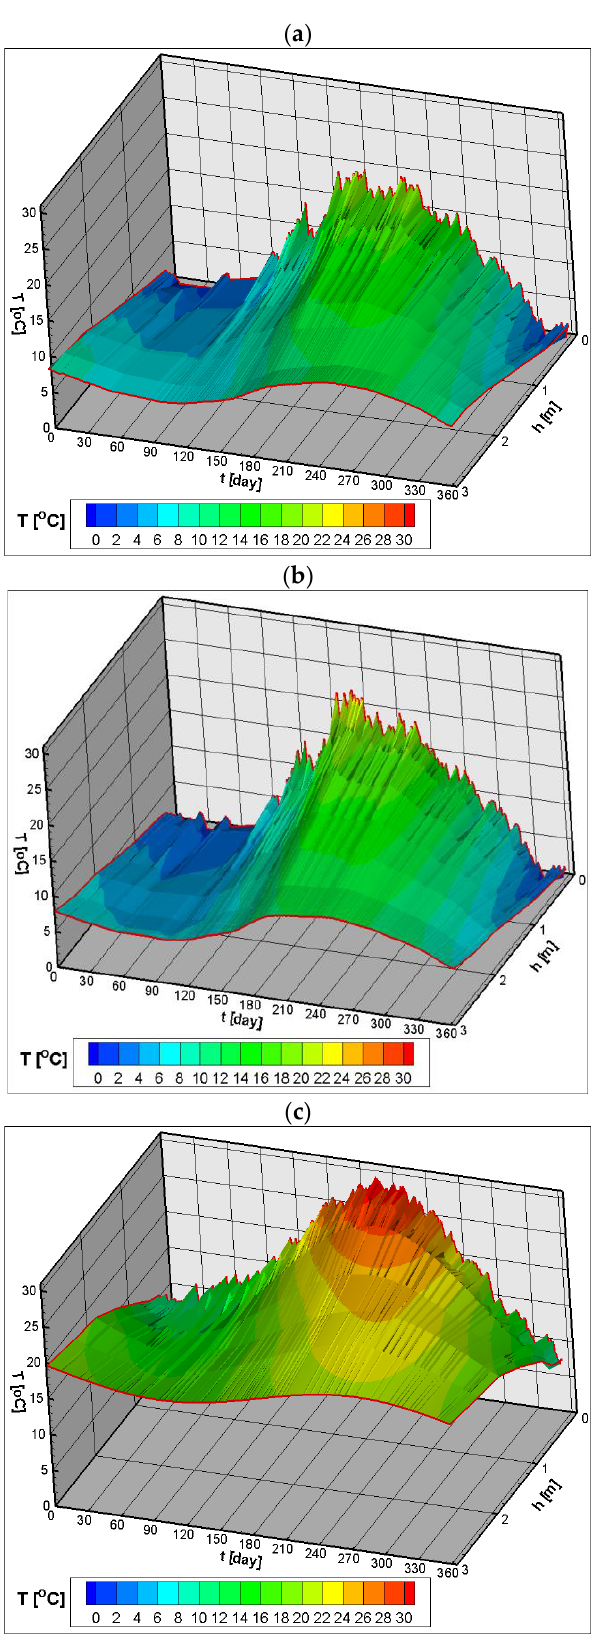
Figure 6. Vertical distribution of temperature in the ground from 0.25 to 3 m as a function of the day of the year for the three measurement points: ( a ) No. 1, ( b ) No. 2, ( c ) No. 3.